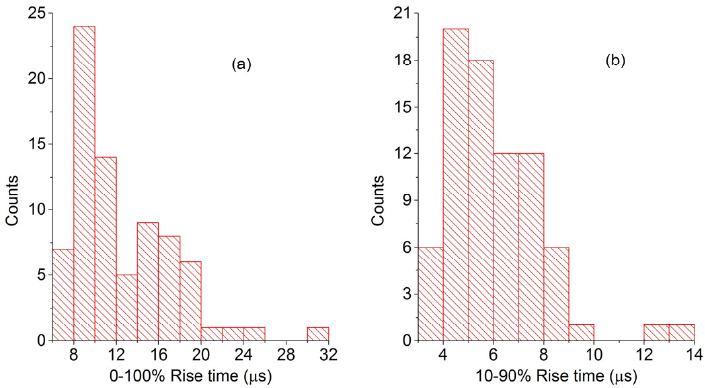
Figure 1. Histogram of rise time: ( a ) Distribution of 0%–100% rise time; ( b ) Distribution of 10%–90% rise time.